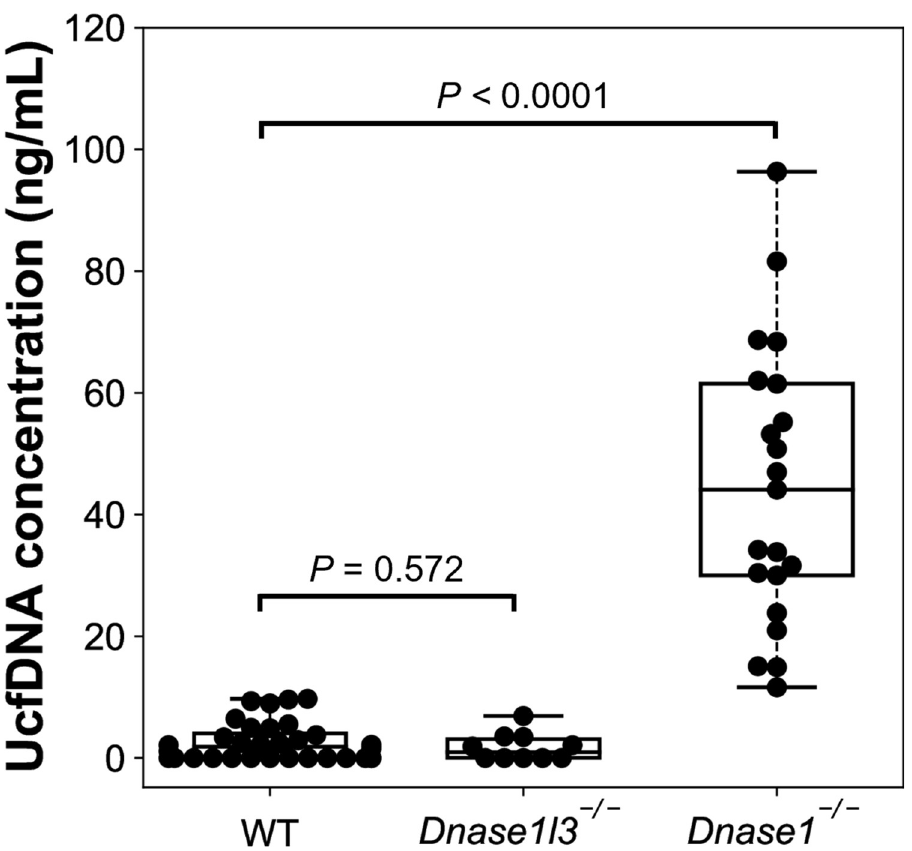
Fig 2. DNA concentrations of ucfDNA in WT, Dnase1l3 -/- and Dnase1 -/- mice. DNA concentrations were measured by Qubit and normalized to the corresponding urine volume. Each dot represents a urine sample pooled from three